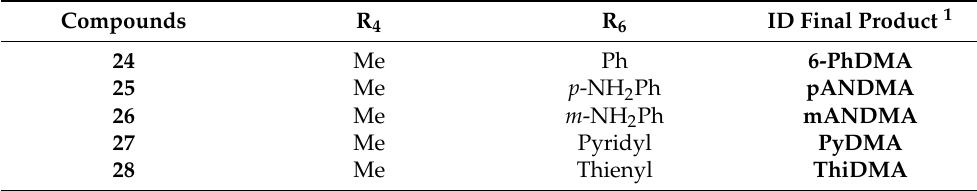
Table 2. R substituents for the B series of TMA analogs.